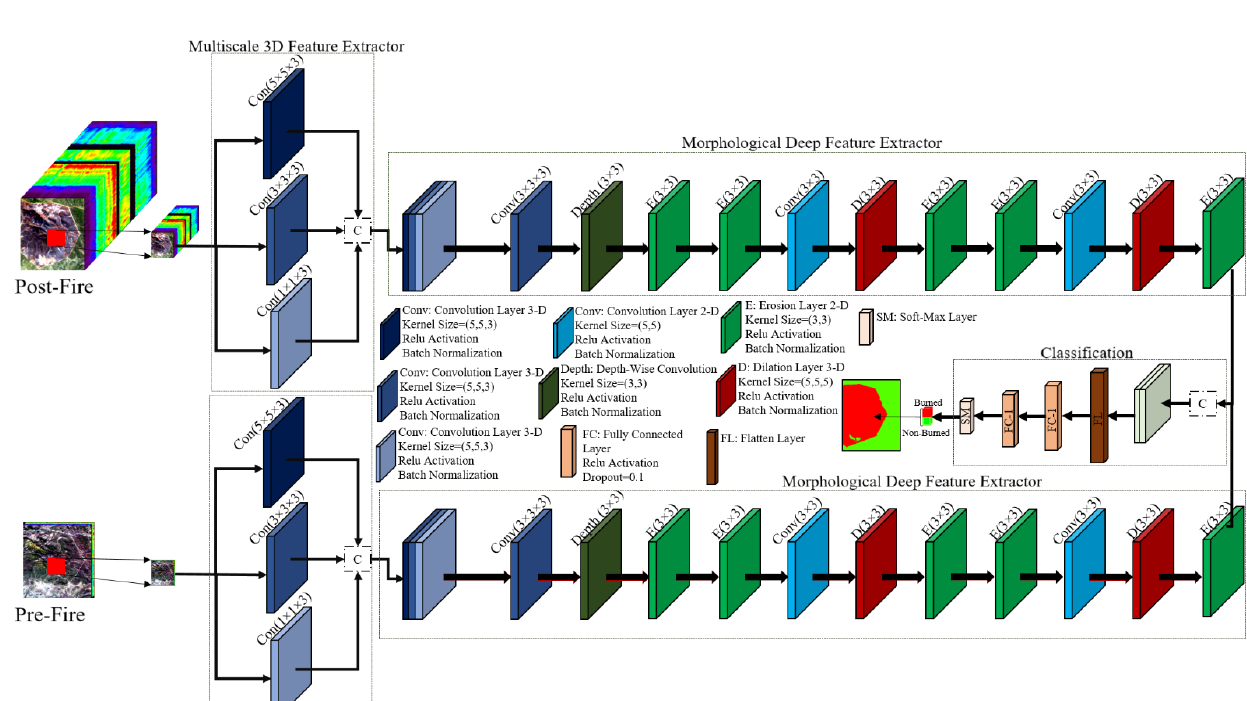
Figure 2. Overview of the proposed DSMNN-Net architecture for burned area mapping.